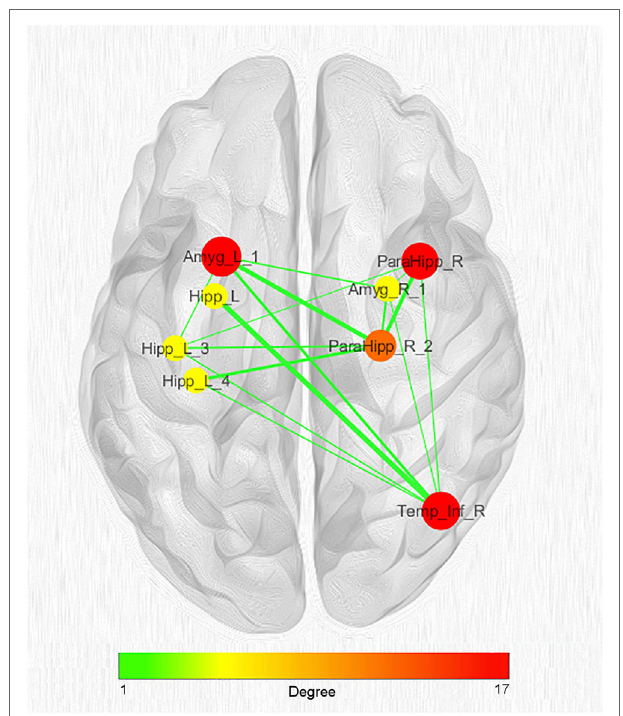
FigUre 8 | Network clustering with k -core decomposition algorithm. Colors and dimensions of nodes indicate their topological degree (smaller node = lower degree; from green to red = from lower to higher values). Thickness of edges indicate the degree of edge betweenness (smaller edge = lower degree). Both node degree and edge betweenness values refer to the original coatrophy